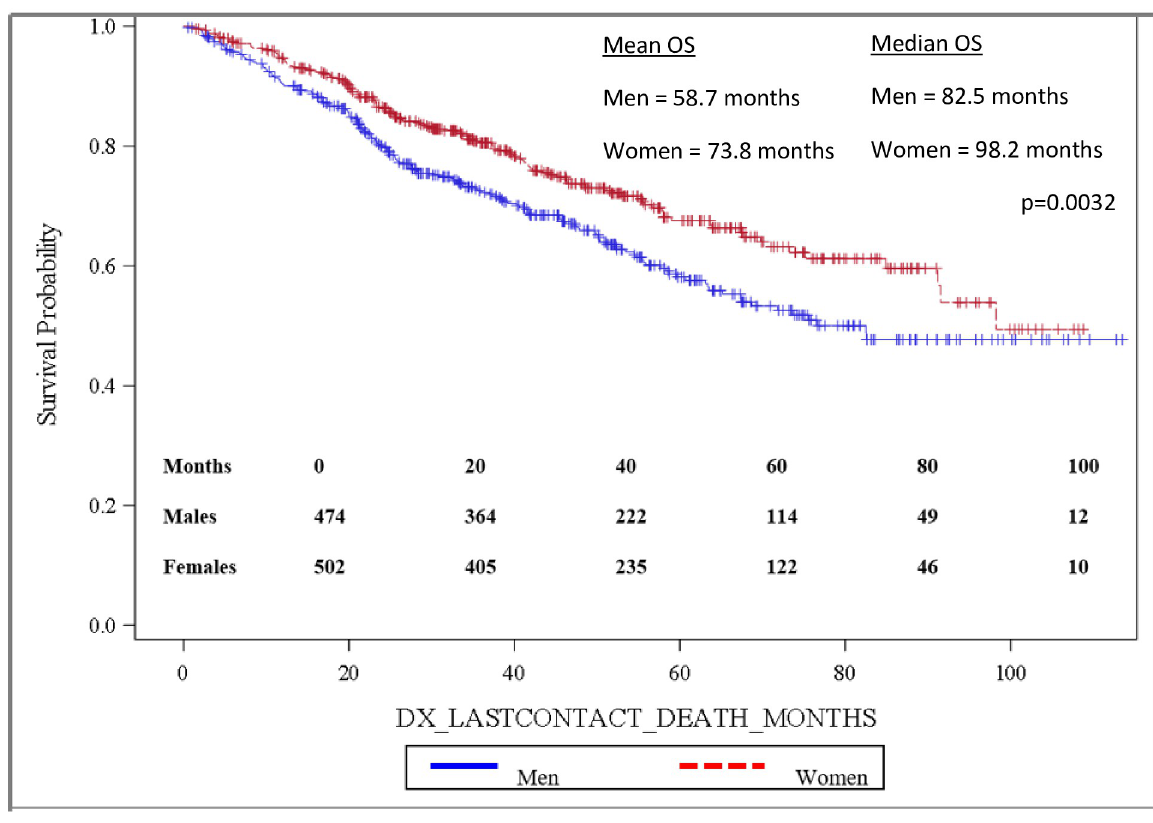
Fig 2. Overall survival by patient